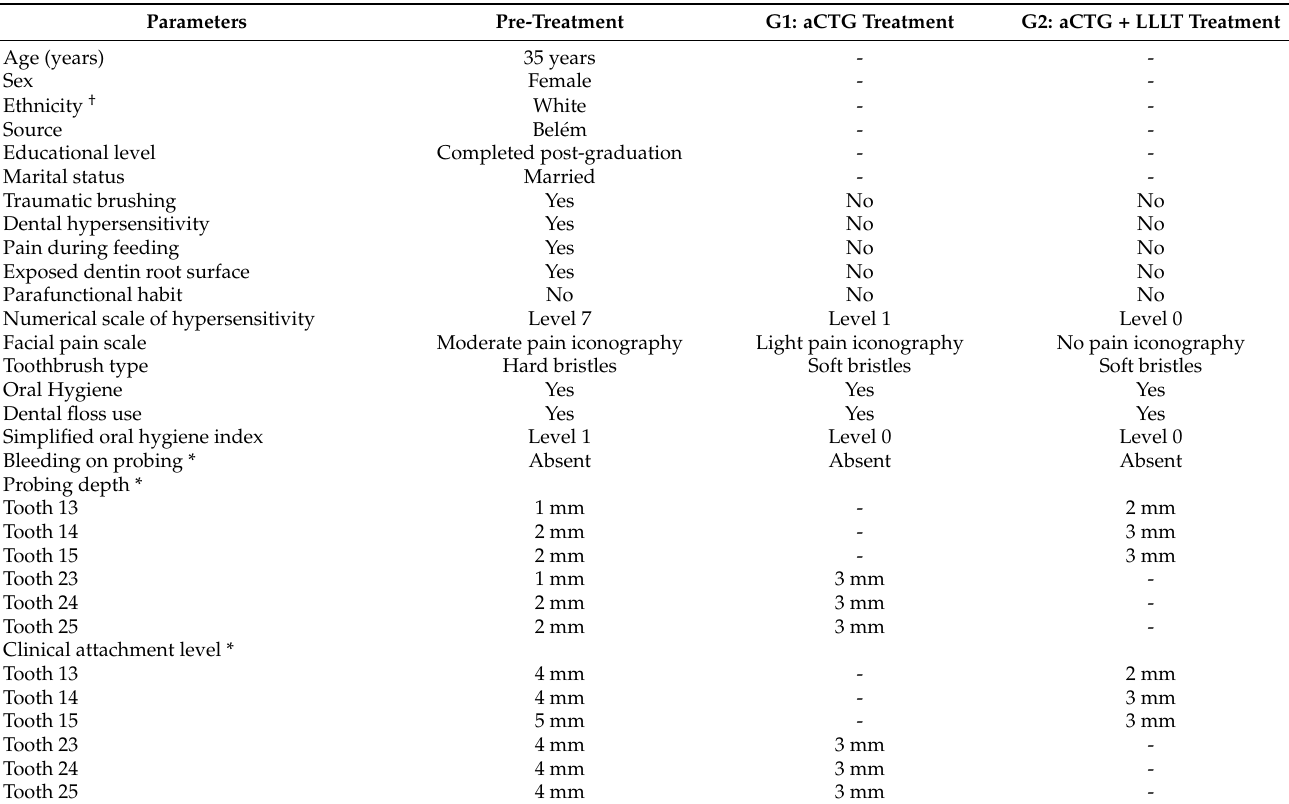
Table 1. Socio-epidemiological and clinical data at baseline and after 90